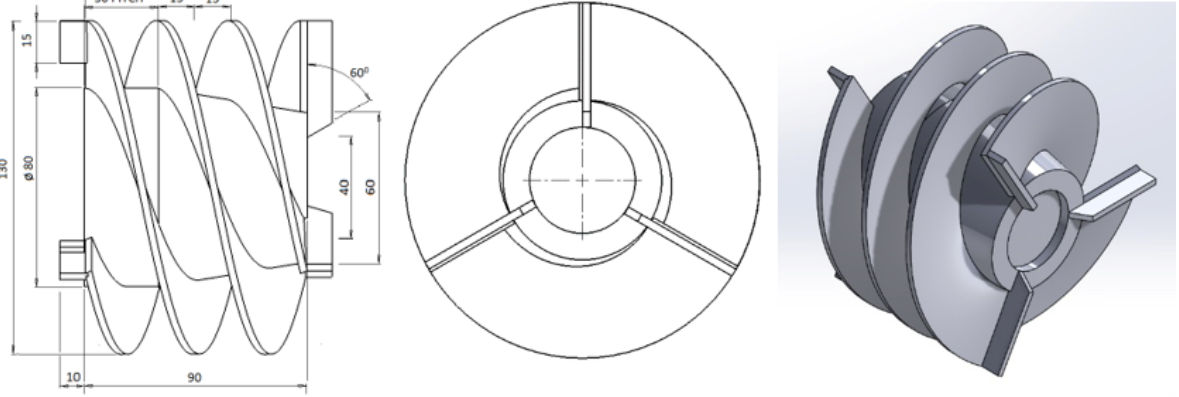
Figure 12. The geometric parameters and isometric view of the rotor with three equidistant blades and pitch length 30 mm.